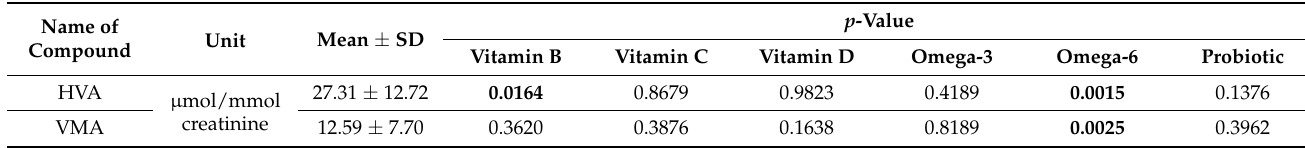
Table 2. Comparison of determined HVA and VMA levels with consumed supplements and Mann– Whitney U test